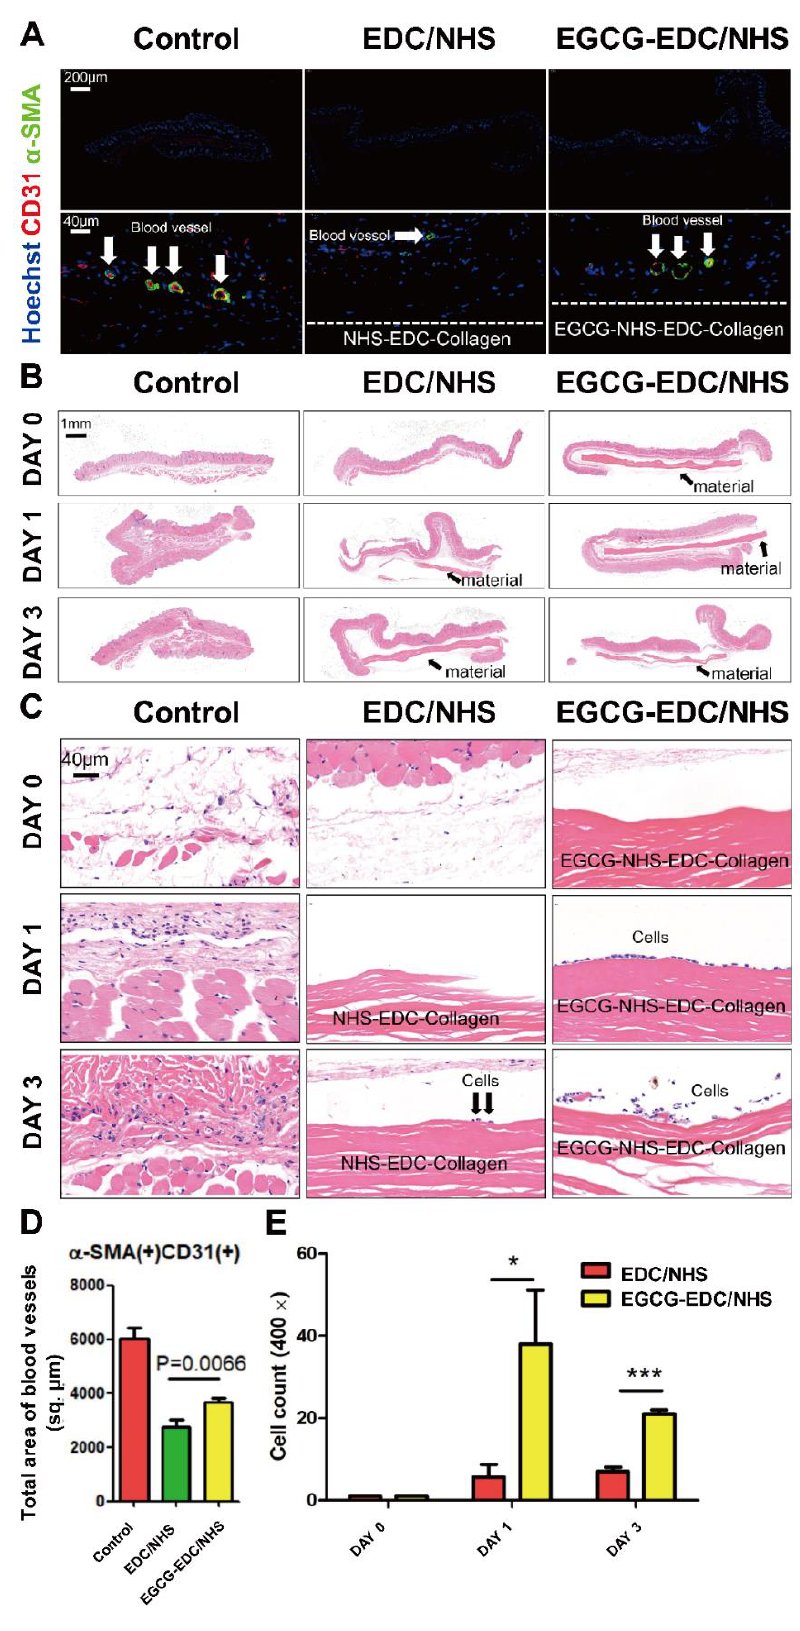
Figure 6. Results of subcutaneous implantation. Immunofluorescence staining of αSMA (green), CD31 (red), and Hoechst (blue) in subcutaneous implantation samples of EDC/NHS-Col and EGCG- EDC/NHS-Col, the control group refers to normal skin ( A ); semi-quantitative analysis of total blood vessel area was calculated in each group ( D ). Recruitment of monocyte/macrophage after subcuta- neous implantation of EDC/NHS collagen membrane, EGCG-EDC/NHS collagen membrane and the control group underwent a sham procedure. HE staining of subcutaneous tissue ( B , C ) and cell counting of monocyte/macrophage ( E ) in NHS/EDC-Col and EGCG-EDC/NHS-Col were conducted on day 0, 1, and 3 post implantations. Arrows indicate material ( B ) and monocyte/macrophage ( C ). Statistical significance was analyzed through the analysis of variance followed by Tukey’s multiple